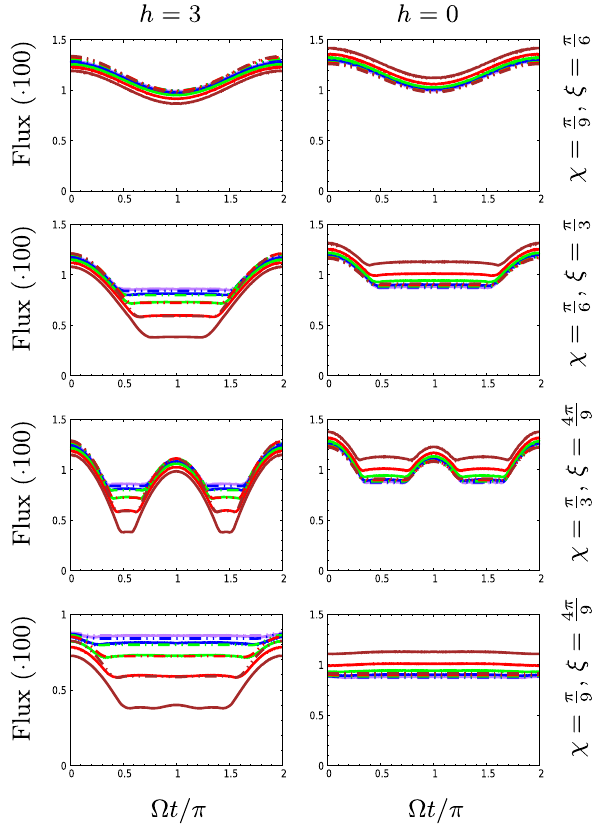
Fig. 15 Analytical pulse profile for two identical, antipodal caps in Schwarzschild metric, R / r h = 3, θ c = 5 o . Purple, blue, green, red and brown lines correspond to (cid:11) = 0 . 1, 0 . 2, 0 . 3, 0 . 4 and 0 . 5 respectively. Solidlinescorrespondtothenumericalresult,dashedlinestoanalytical. The rows, from top to bottom, correspond to Beloborodov classes I, II, III and IV. For h = 3, the flux is overestimated at maximums and underestimates at minimums. For h = 0 is in general overestimated